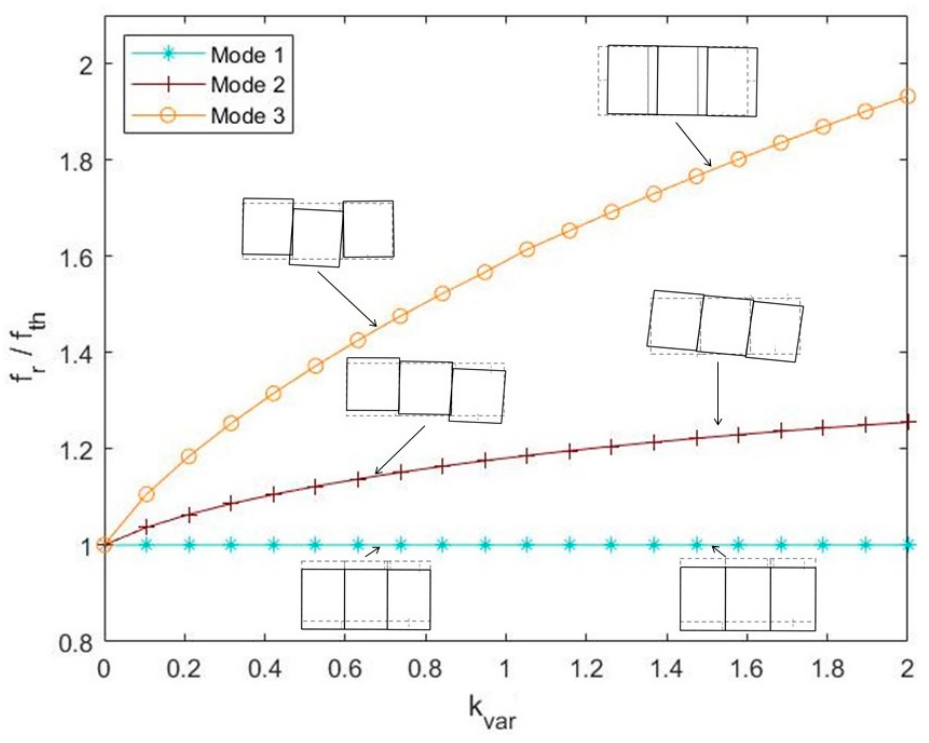
Figure 3. Variation of the modes and of the natural frequencies of the system from 1 to 3 as a function of k var .